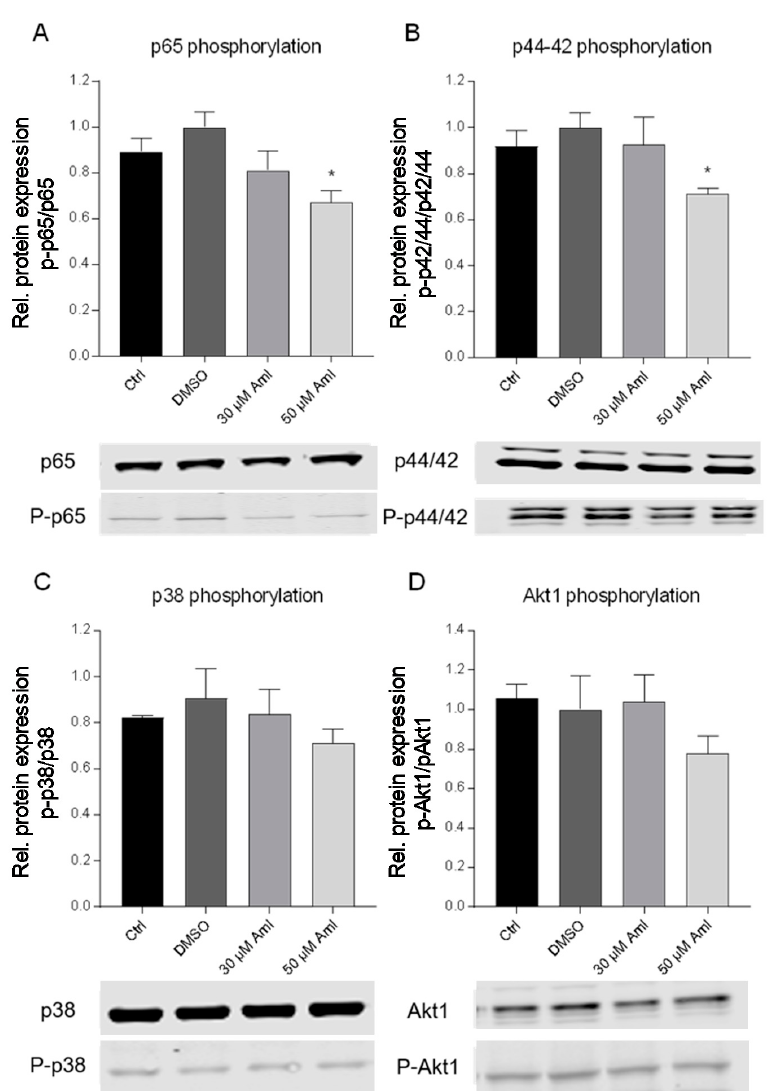
Figure 6. Regulation of genes involved in melanoma development. Activation of p65 ( A ), p42/44 ( B ), p38 ( C ) and Akt1 ( D ) in SK-Mel-28 cells treated with amlexanox at the indicated concentrations, as assessed by Western blot analysis with phospho-specific antibodies. The signals for phosphorylated proteins were normalized to the respective total protein levels and additionally against the loading control β -actin. The blots show a representative result; the diagrams show the densitometric analysis of all the experiments ( n = 3); * P < 0.05 in comparison with vehicle-treated cells.